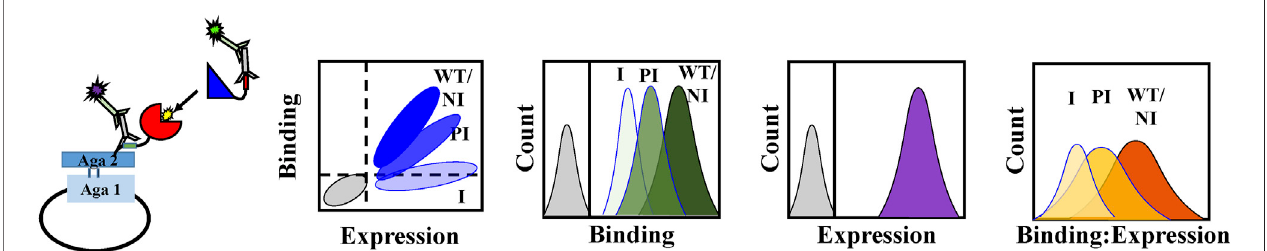
FIGURE 1 | Schematic representation of the rapid mapping of the binding site of a natively unfolded antitoxin through mutational scanning. Aspartate and arginine mutants of MazE6 are introduced at the predicted ligand binding interface (31-82 residue stretch). The mutant is displayed as a fusion protein on the yeast cell surface and its binding to the cognate partner is observed by fl ow cytometry. Introduction of a mutation in the ligand binding site in the MazE6 protein may generate different populations, depending on the location of mutation. Non-interacting residues marked as NI will not change binding upon mutation, similar to WT. However, both partially interacting residues marked as PI and interacting residues marked as I will result in a reduced binding upon mutations, with the hot spot interacting residues showing the maximum effect on binding. To estimate the relative toxin binding af fi nity for MazE6 variants we used mutational scores based on binding: expression fl uorescence intensities, namely MFI ratio